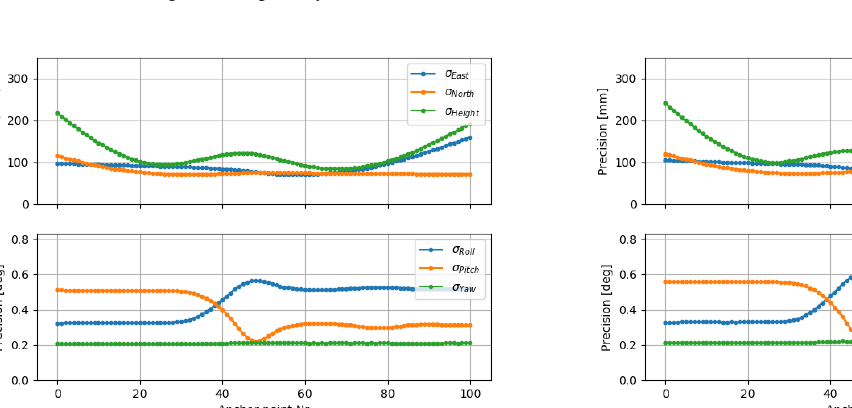
Figure 8. Trajectory of the platform back represented by the Figure 9. Results of platform back , scenario 1. Top: Precision individual components of the anchor points. Top: Position of the of the anchor point positions in East, North and Height. Bottom: anchor points in East, North and Height. Bottom: Rotations Precision of the anchor point rotations (roll, pitch, yaw). angles (roll, pitch, yaw).